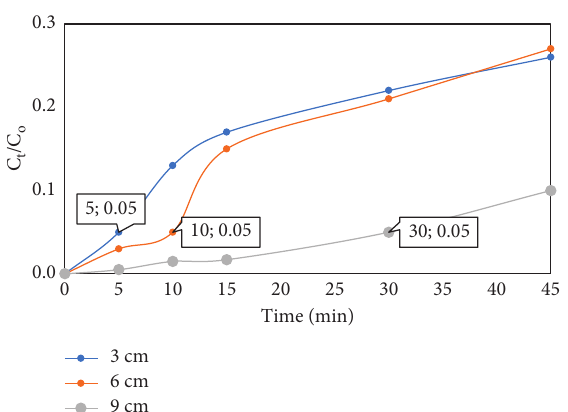
Figure 3: Breakthrough points for cadmium adsorption at different bed depths.